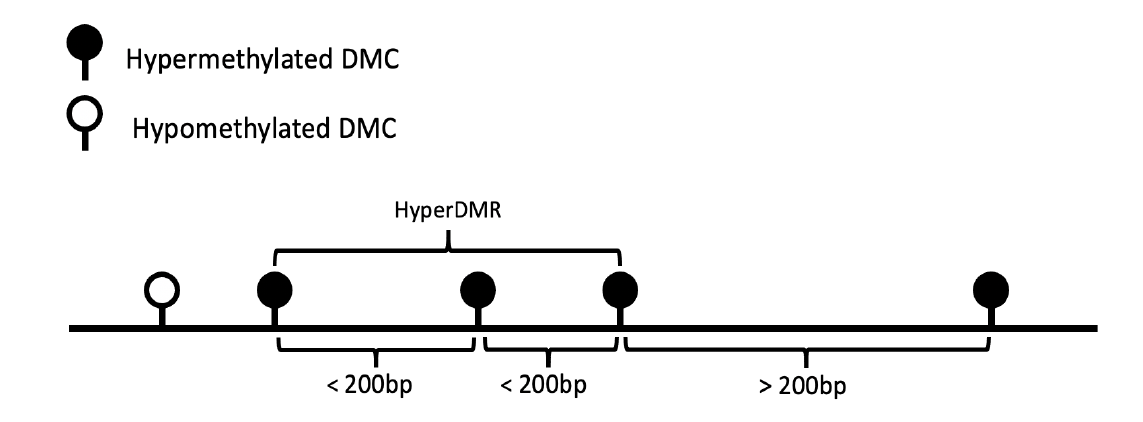
Figure 10. An example of a hypermethylated